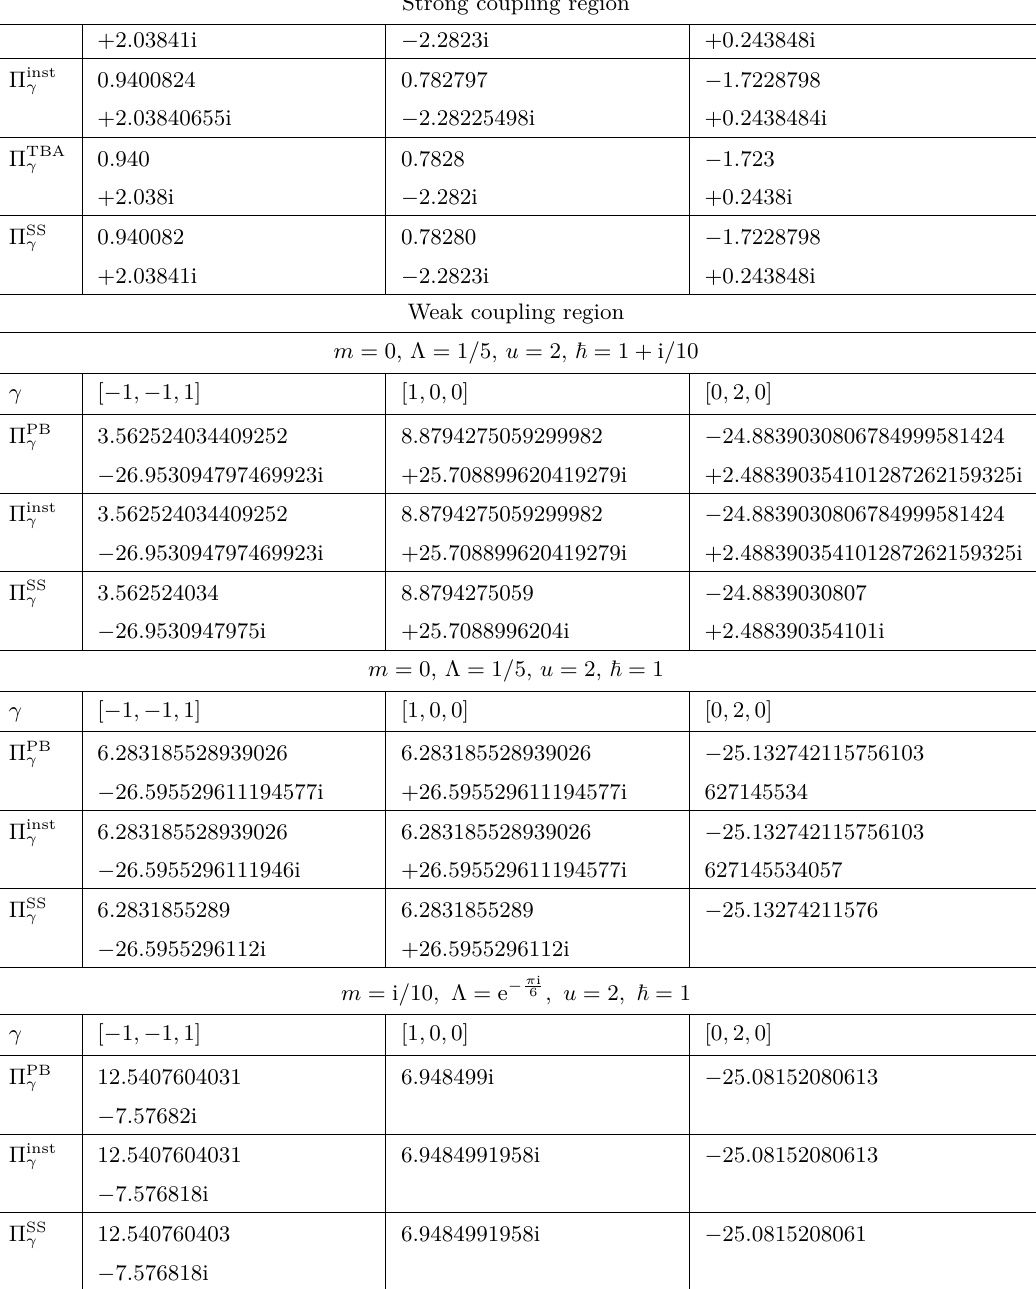
Table 1. Summary of results of numerical computation of Π γ for various moduli, charges and values of ~ . Π PB , Π SS , Π TBA γ γ